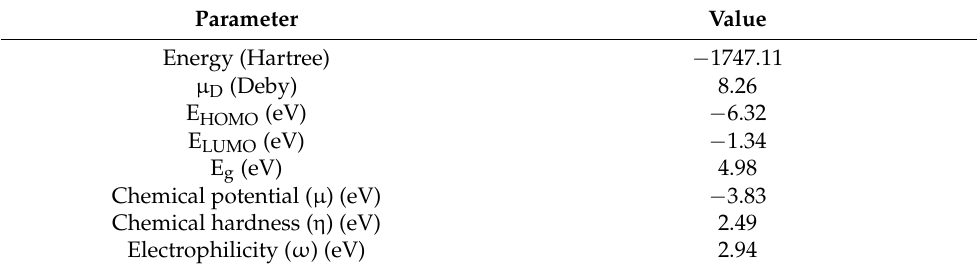
Figure 3. The B3LYP/6-31 + G(d, p ) optimized geometry of 5a (distance in Å).